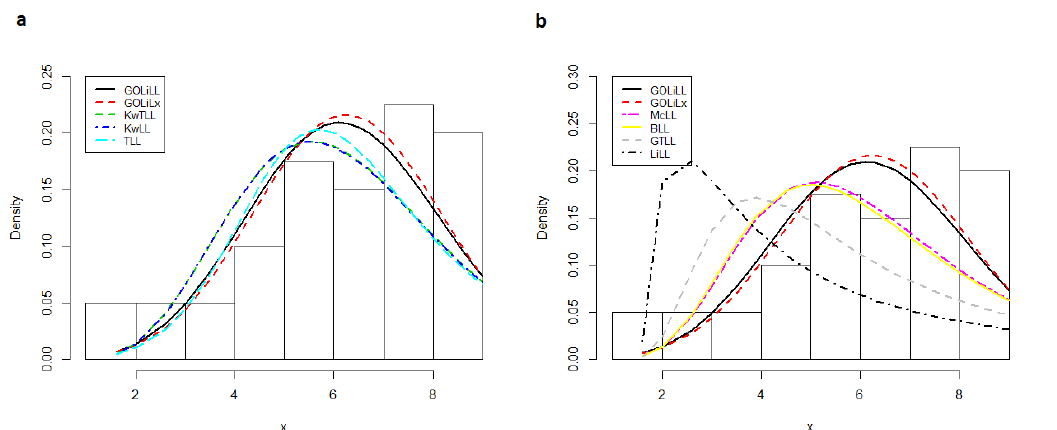
Figure 5 - The estimated GOLiLL and GOLiLx pdfs and other estimated pdfs for time-to-failure data. ( a ) The estimated GOLiLL, GOLiLx, KwTLL, KwLL and TLL densities. ( b ) The estimated GOLiLL, GOLiLx, McLL, BLL, GTLL and LiLL densities.